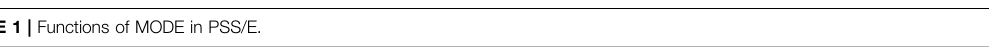
TABLE 1 | Functions of MODE in